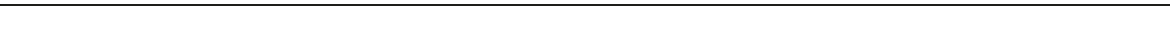
Fig. 1 Experimental rationale, task and visualization of individual trial activity. a In telecommunications, multiple signals can be conveyed along a single channel by interleaving samples of each, thus increasing the amount of information transmitted by a single physical resource. Here we investigated whether the brain might employ a similar strategy: do neurons encode multiple items (A and B) using spike trains that alternate between the fi ring rates corresponding to each item, at some unknown time scale? Such a strategy would preserve information about both items, in contrast to alternatives such as winner-take-all, summation, or averaging, which involve varying degrees of information loss. b Sound localization task. Two monkeys were successfully trained to report one or two simultaneous (bandlimited noise) sounds by saccading at them. See Supplementary Figure 1 for accuracy. c Eye traces of the saccades towards one (left) or two targets (right) during a sample session. d Time-and-trial aggregated dual-sound responses resemble the averaging more than the summation of single-sound responses. For 81% of the triplets tested, the absolute values of the Z -score of each dual-sound response relative to the average were smaller than those relative to the sum. e , f Visualization of individual trials of two IC neurons in which dual-sound responses alternate between fi ring rates corresponding to single-sounds, across trials for the neuron in e , or within trials for the neuron in f . In each panel, the red and blue shaded areas indicate the median and central 50% of the data on the single-sound trials. The black traces are the individual trials, for single-sound and dual-sound trials as indicated above the panel. For the neuron in e , individual traces on dual-sound trials were classi fi ed based on whether they matched the responses to single-sounds A and B (A vs. B assignment score, see Methods) and are plotted in two separate panels accordingly. For the neuron in f , the fl uctuations occurred faster, within trials, and are plotted in the same panel. See Supplementary Figure 4 for peristimulus time histograms and frequency sensitivity of these two example